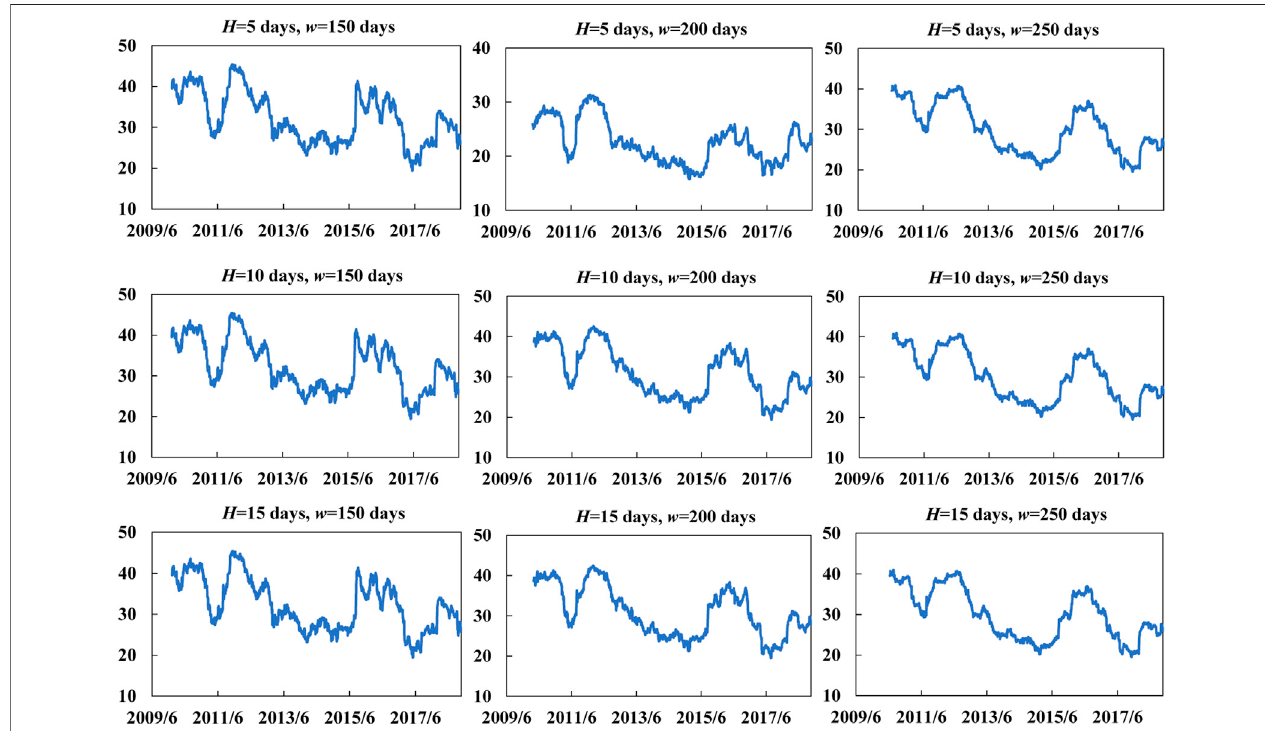
FIGURE 7 | Sensitivity of total return connectedness to forecast horizons H and window widths w . ( H (cid:1) 5, 10, 15; w (cid:1) 150, 200, 250).